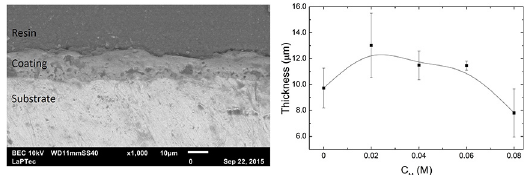
Figure 3. (left) SEM micrograph of a typical cross section of a samples treated with C